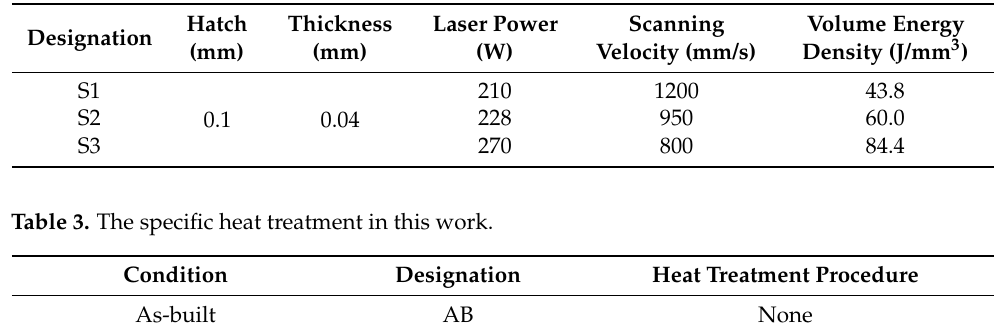
Table 2. The parameters of the LPBF process.